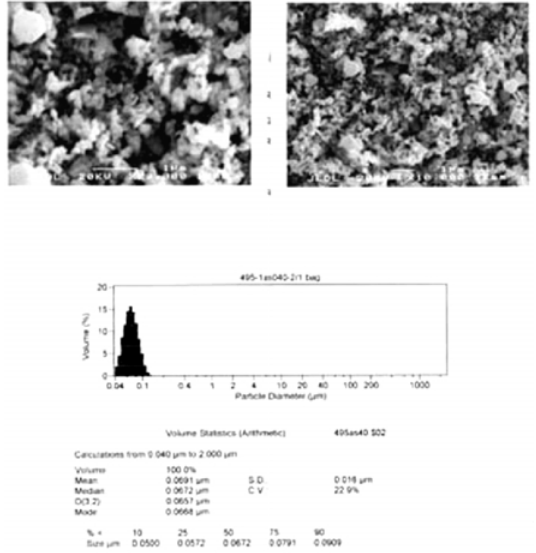
FIGURE 6 Particle size distribution and SEM pictures, #495 (Ag = Pt 95:5)